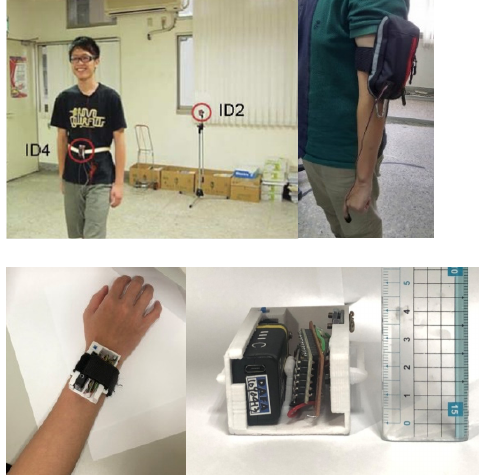
Figure 1. Pulmonary rehabilitation: a biosensor module-based system ( top left ) [3]; an arm bag-based system ( top right ) [4]; the proposed wrist-based wearable system; the prototype ( bottom left ); and the system size ( bottom right ).